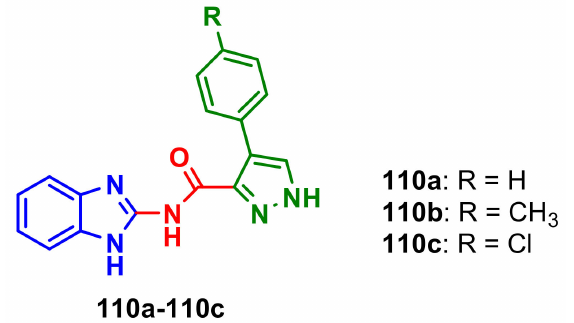
Figure 4. Benzimidazole–pyrazoles 109a – 109d